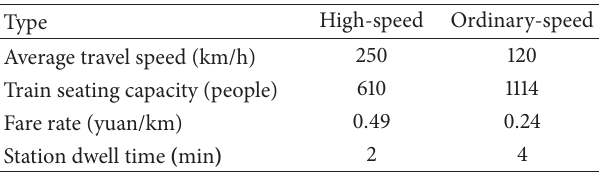
Table 1: Basic parameters of train